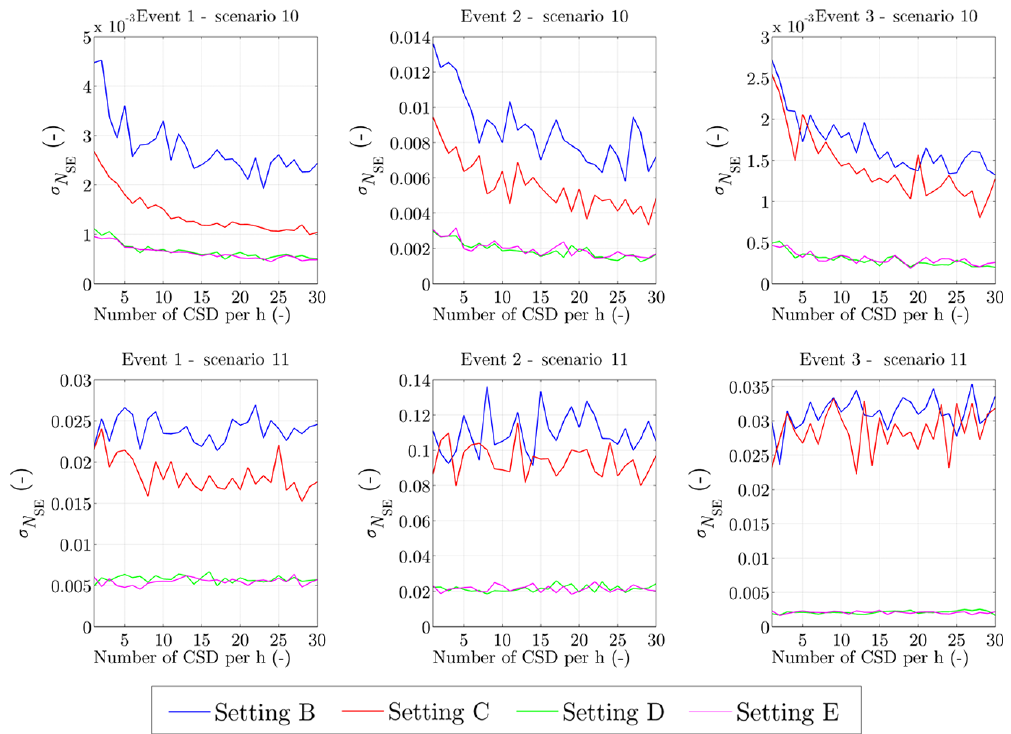
Figure 17. Variability of model performance expressed as σ N assuming a lead time of 4h, for experimental scenarios 10 (upper row) and 11 (bottom row), during the three considered flood events in the Bacchiglione